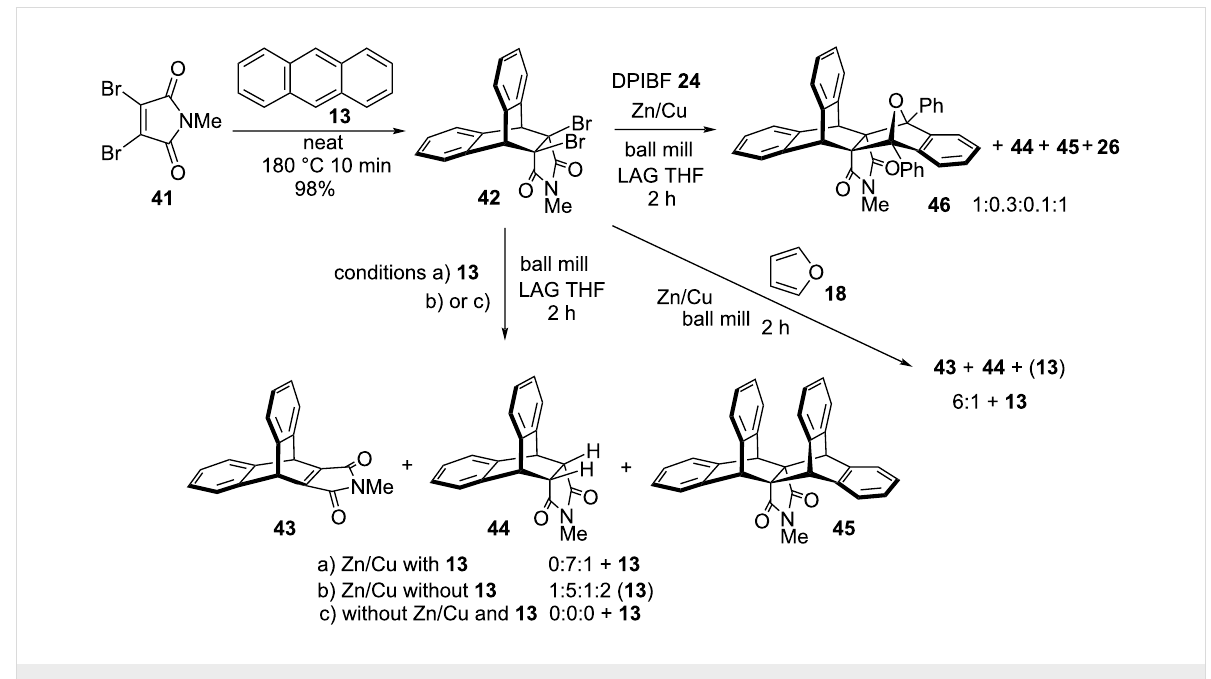
Scheme 3: Reactivity of bicyclo[2.2.2] dibromide 42 with